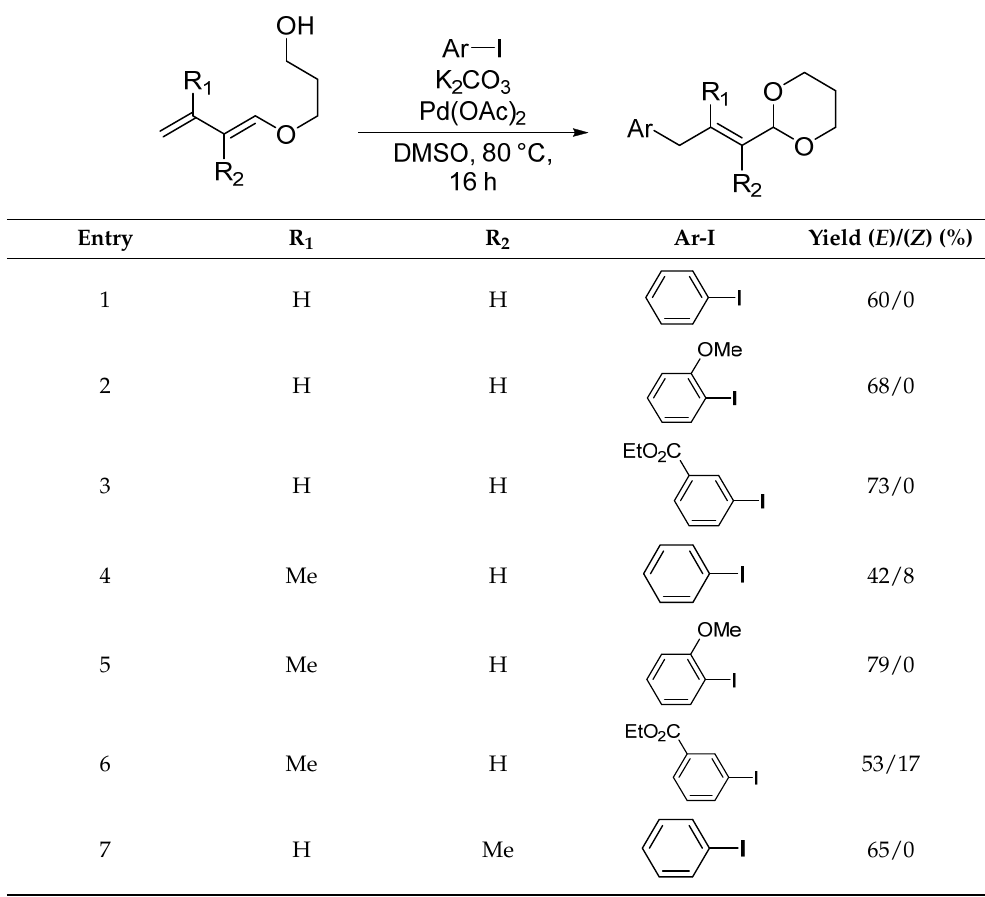
Table 10. Generalization of cyclizing Heck conditions.